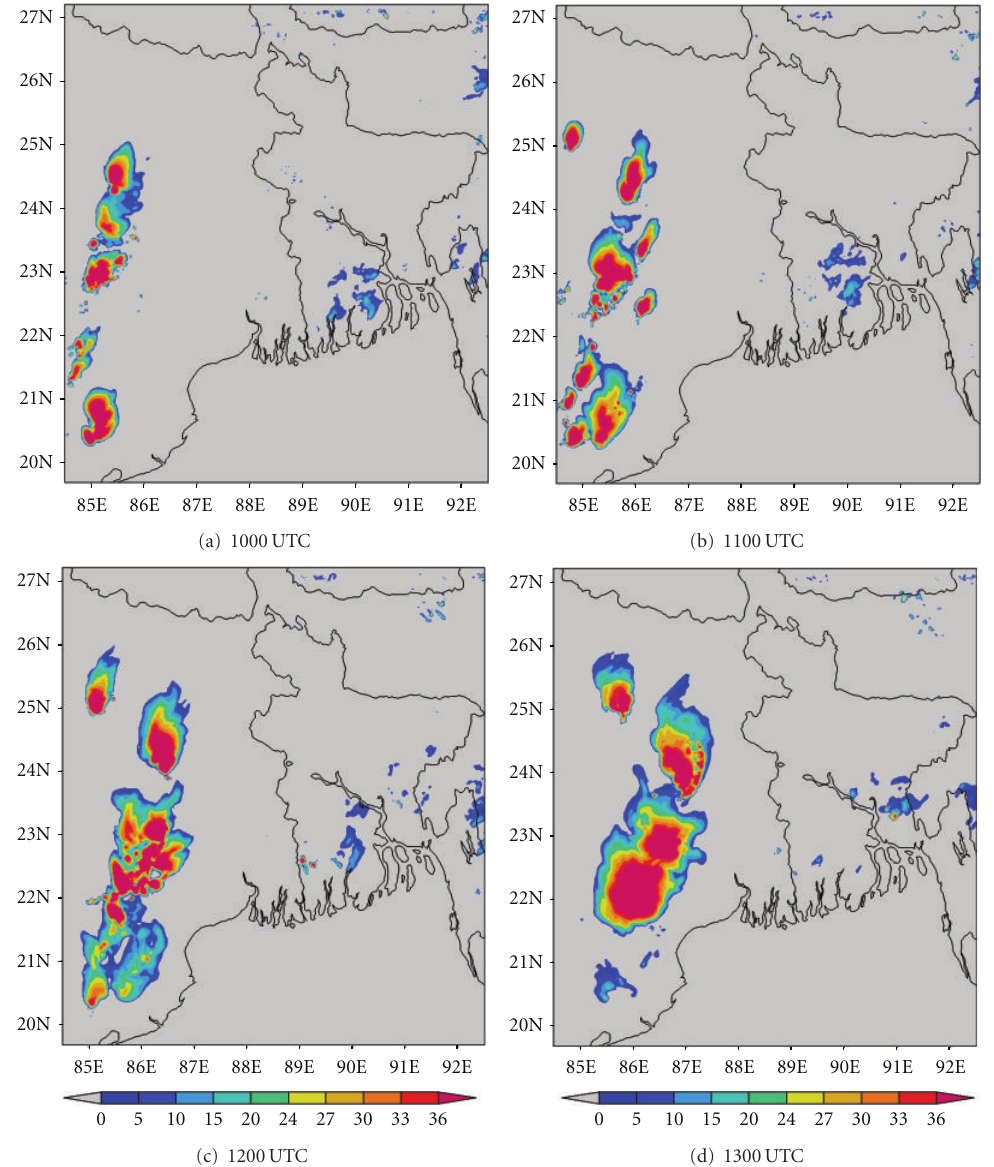
Figure 6: ARW-model-simulated composite radar reflectivity (dBZ) from 1000 to 1300 UTC on 03, May,